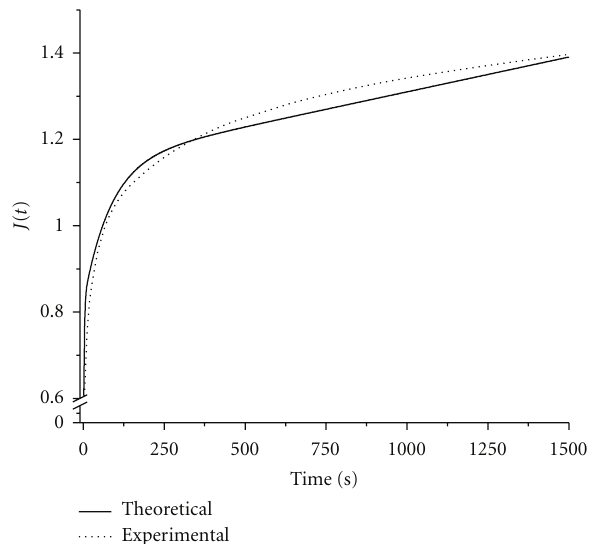
Figure 4: Observed reduced EOM creep function, and theoretical function derived from the reduced relaxation